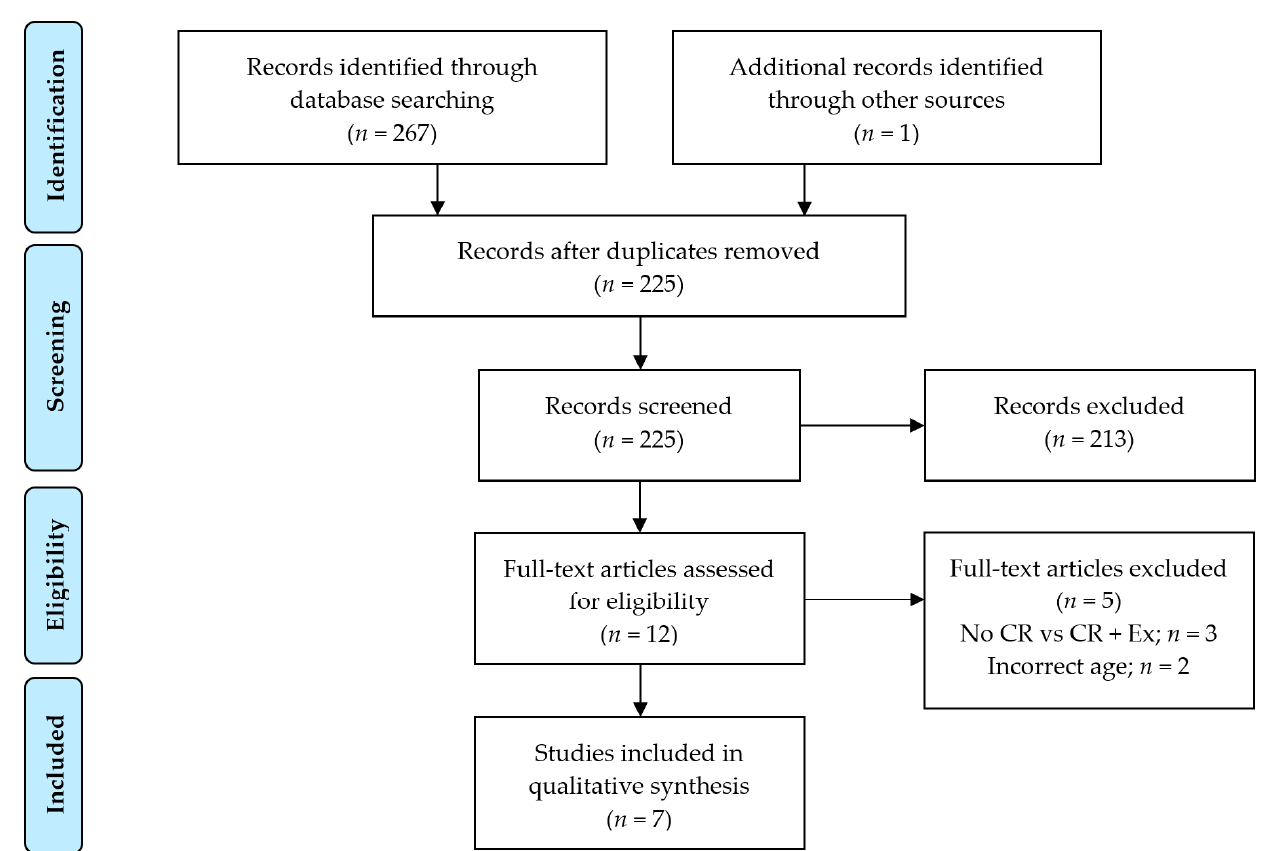
Figure 1. Flow diagram of included and excluded studies. Initial search conducted 20 December 2020; last search conducted 12 February 2021. Abbreviations: CR—caloric restriction; Ex—exercise.